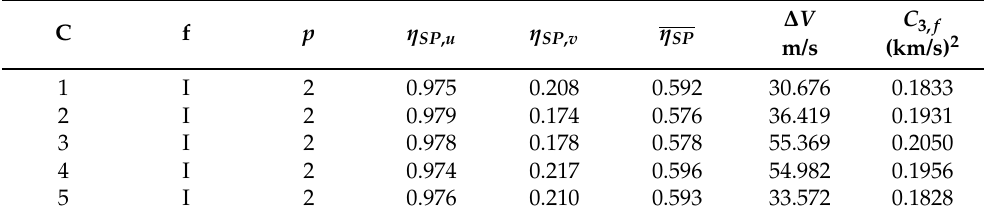
Table 1. SEL2 escapes performance—fixed t f = 90 days, free C 3